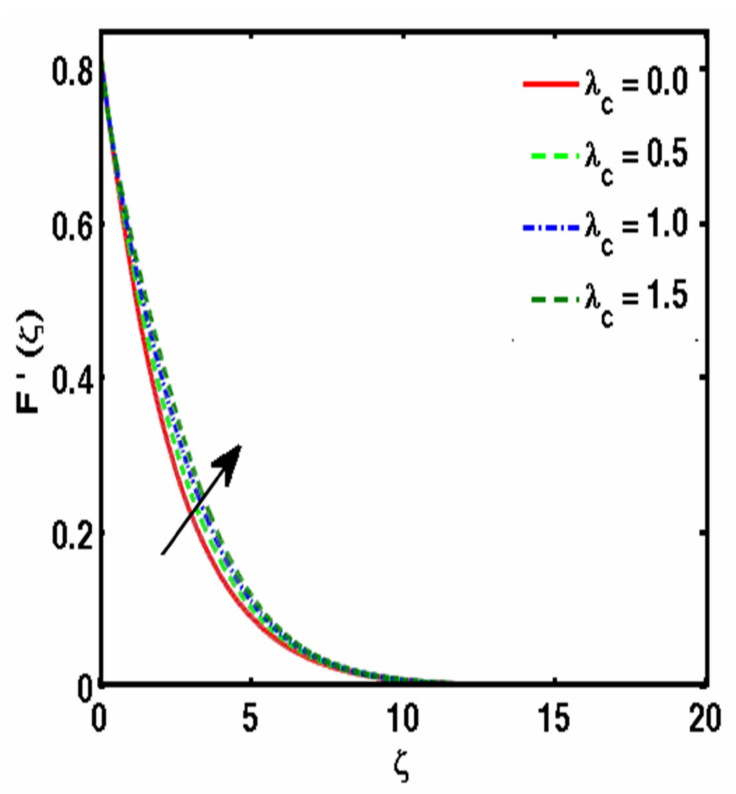
Figure 6. Variation of λ c and F (cid:48) ( ζ )